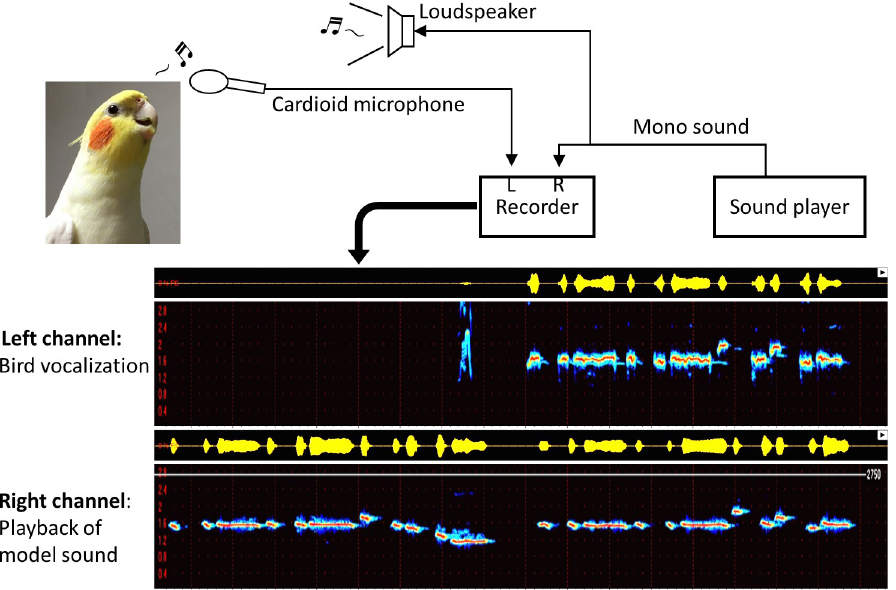
Fig 5. A schematic diagram of the updated recording system. All recordings of singing by the birds used for the analyses in Results section were obtained using this system. Therefore, the stimulus sounds presented to the birds were played back from the PC, not live performance by the